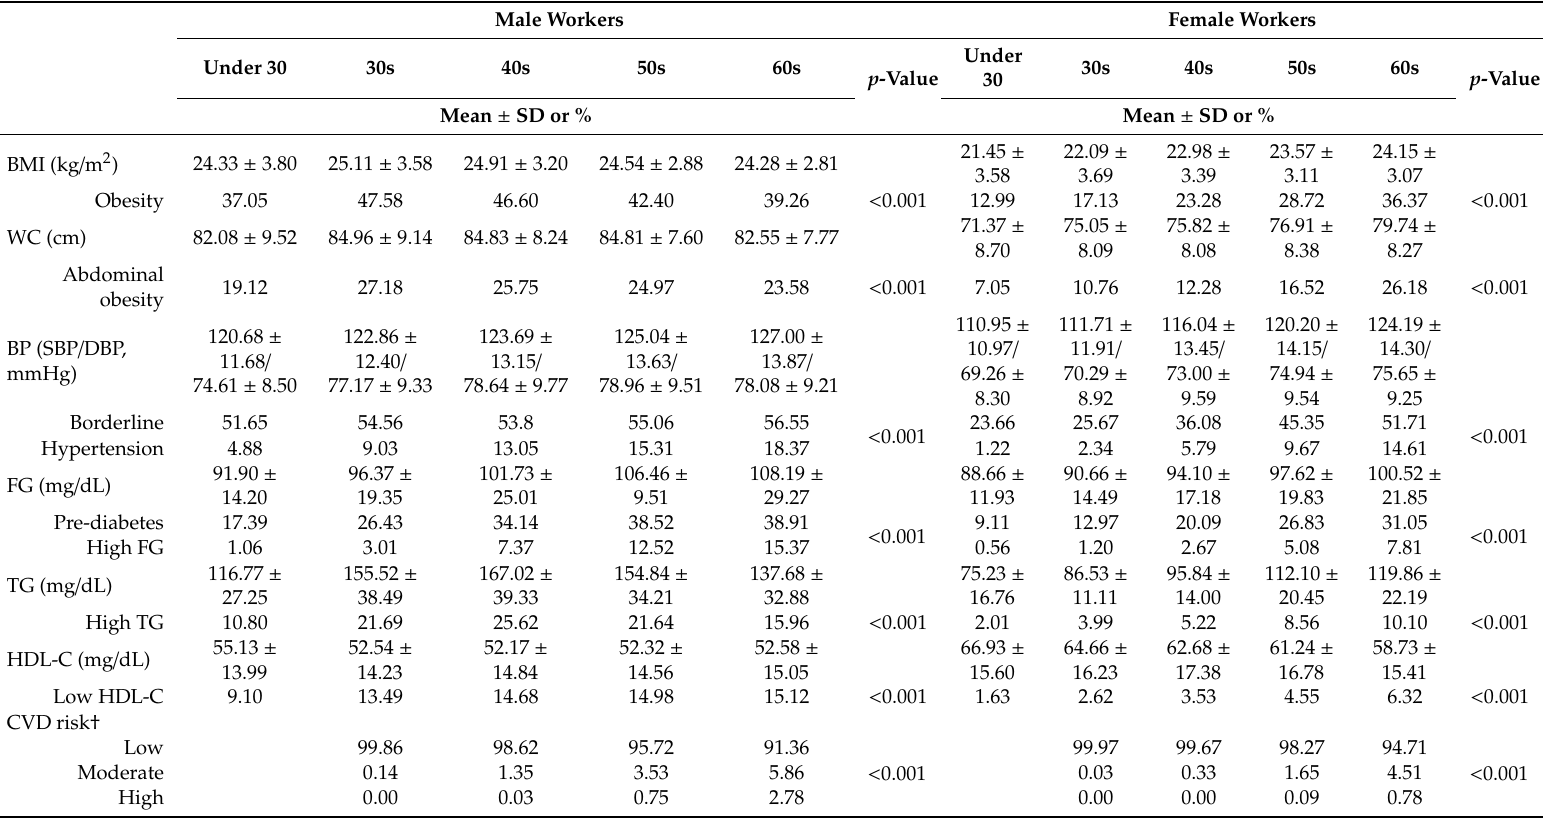
Table 5. Sex di ff erences of cardiovascular disease (CVD)-related health status by age. Male